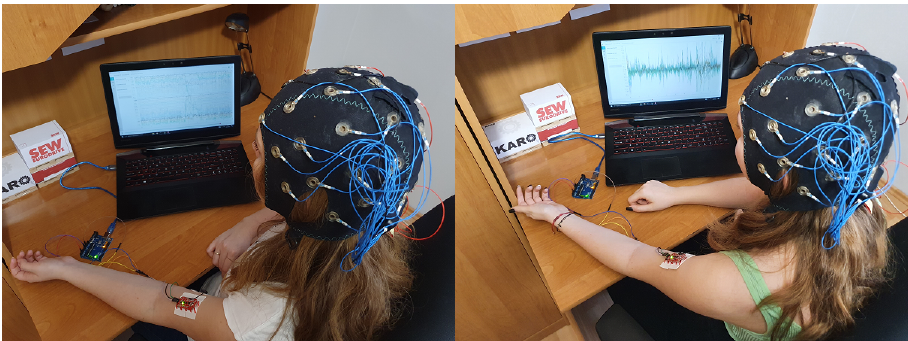
Figure 2. Presentation of electrodes configuration and devices used in research.